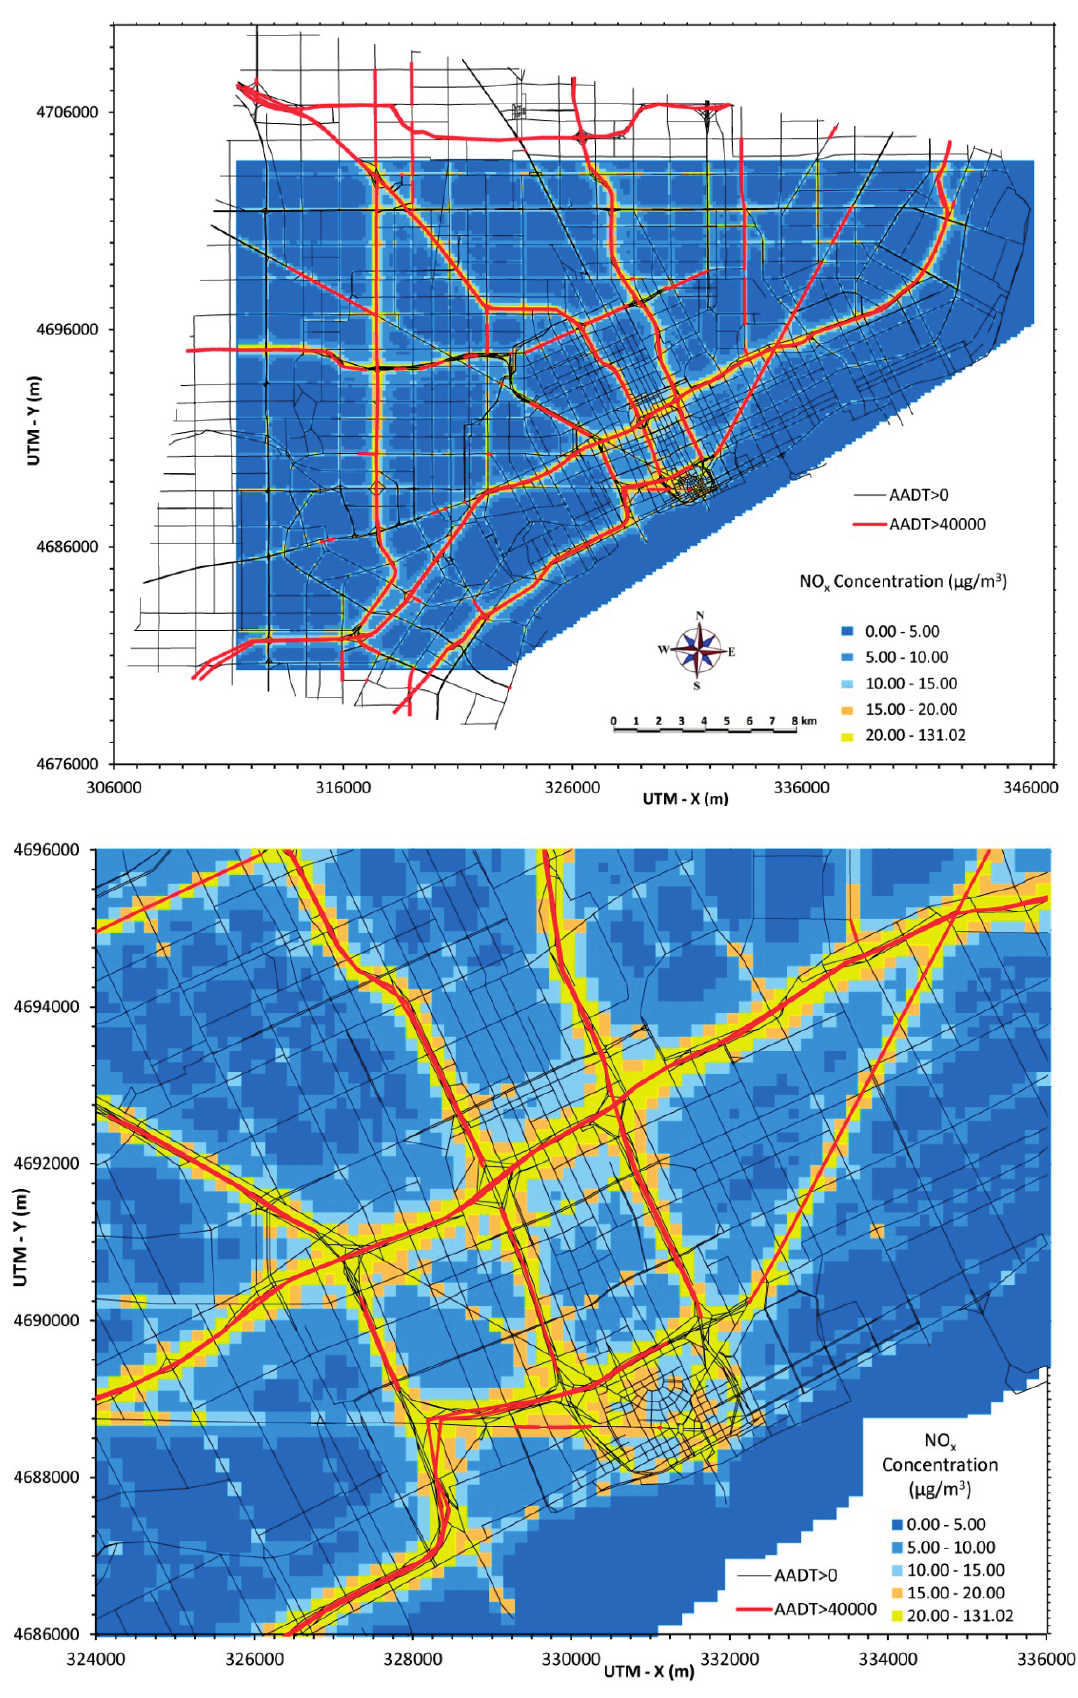
Figure 4. Annual average NO x concentrations from traffic emissions across Detroit (30 × 40 km area, top) and in central area (10 × 12 km area,